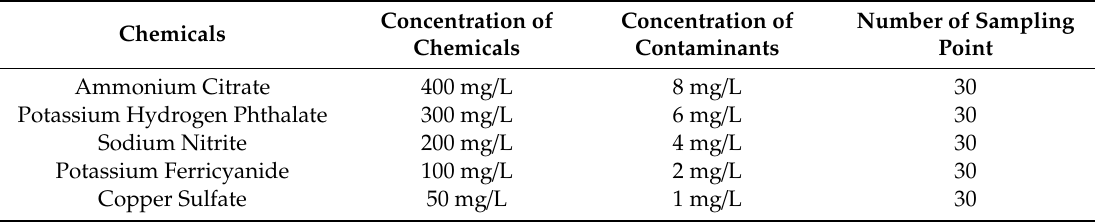
Table 1. Information on characteristic contaminants used for training.